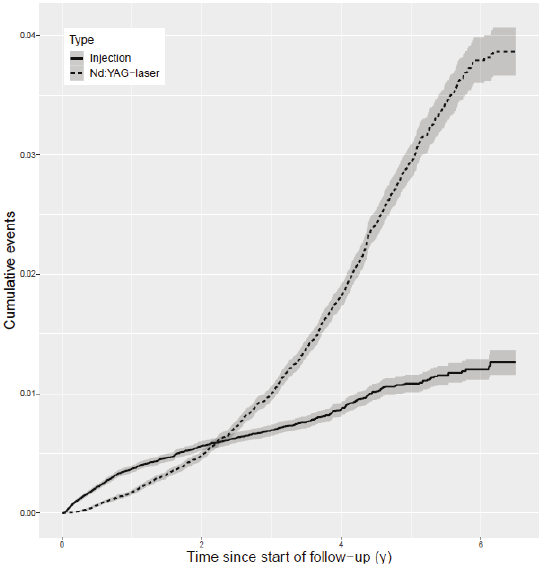
Figure 1. Kaplan-Meier cumulative events curves with 95% confidence intervals.